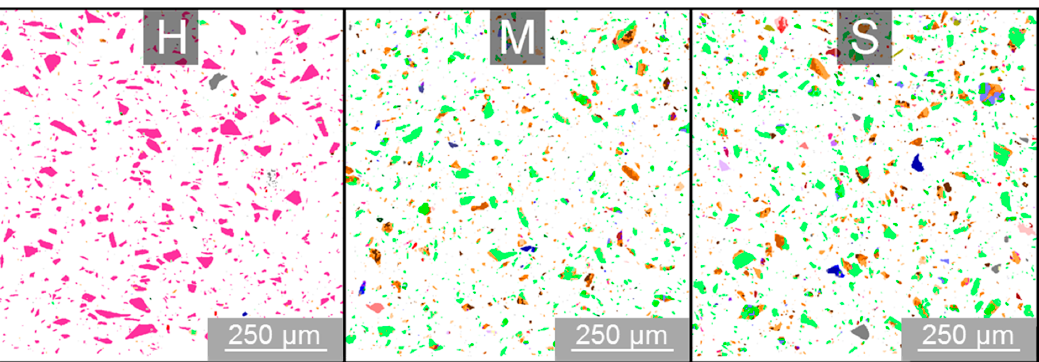
Figure 11. Overview of the three slag samples H, M, and S: MLA false color images display the difference between sample H and samples M and S.